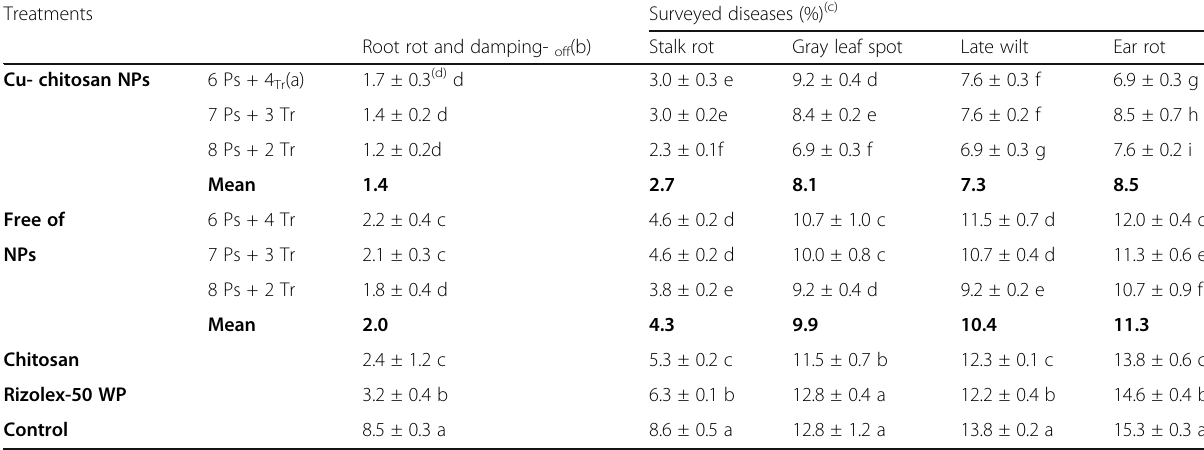
Table 1 Efficacy of using fermented maize wastes as grain dressing against maize diseases under field conditions Treatments